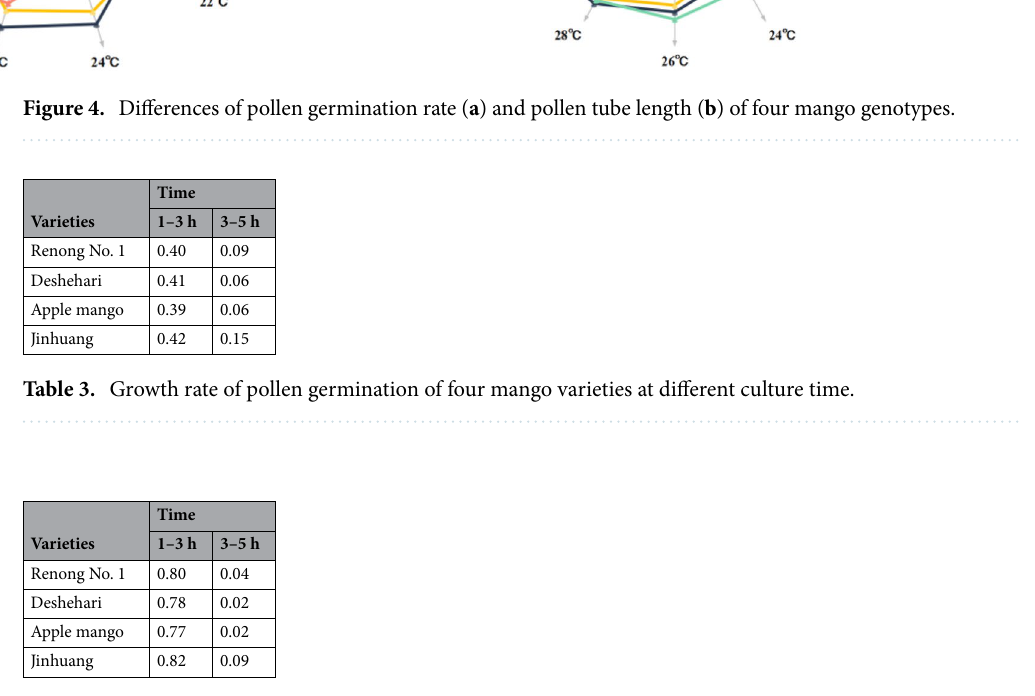
Table 4. Growth rate of pollen tube length of four mango varieties at different culture